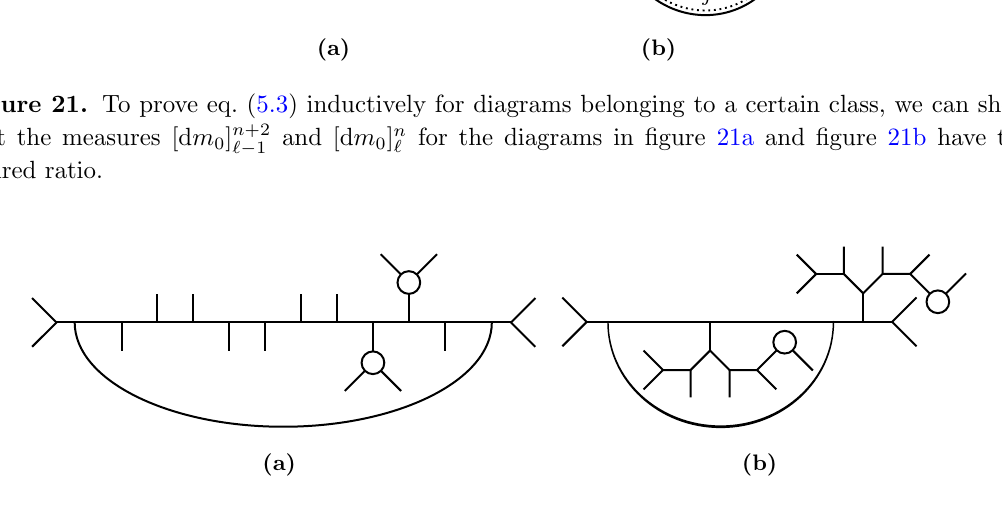
Figure 22. A diagram that contains a loop with many edges attached to both its inside and its outside (an example is shown in (cid:12)gure 22a) is dual to a diagram (e.g. (cid:12)gure 22b) where the corresponding loop has one edge attached to its inside and two edges attached to its